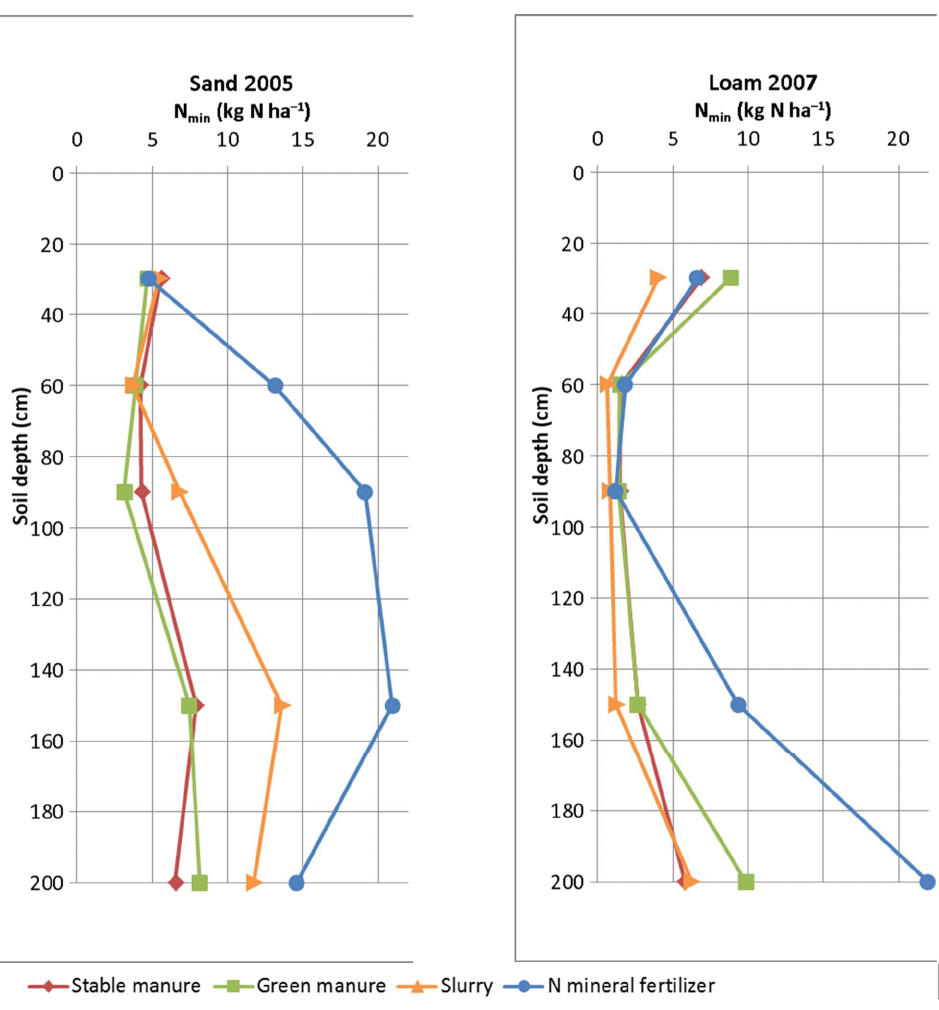
Figure 1. Development of N min amounts after continuous fertilization with stable manure, green manure, slurry, and N-mineral fertilization in the soil depth profile after 14 – 16 years of long-term experiments (sandy soil: ms = ±2.33 kg N ha −1 ; loamy soil: ms = ±1.49 kg N ha −1 ). manure, slurry, and N-mineral fertilization in the soil depth profile after 14–16 years of long-term experiments (sandy soil: ms = ± 2.33 kg N ha − 1 ; loamy soil: ms = ± 1.49 kg N ha − 1